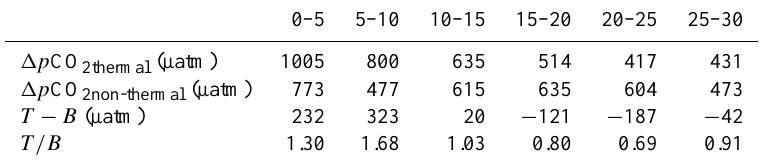
Table 4. Calculated (cid:49)p CO 2thermal , (cid:49)p CO 2non-thermal , T − B , and T/B values for each salinity interval in the Delaware